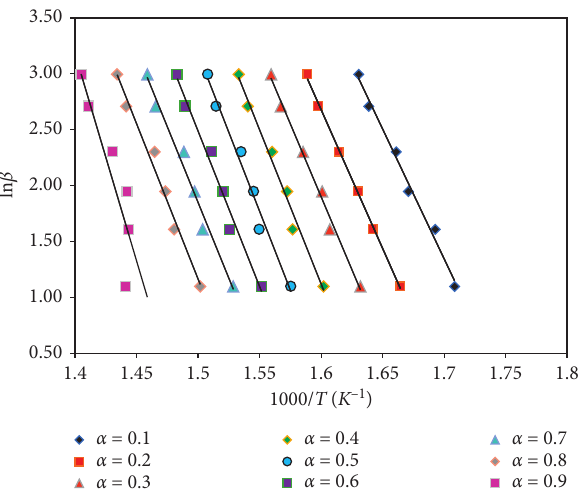
Figure 6: OFW plots ln β versus 1000/ Τ for sample PNVP- co - PHMA 80–20.